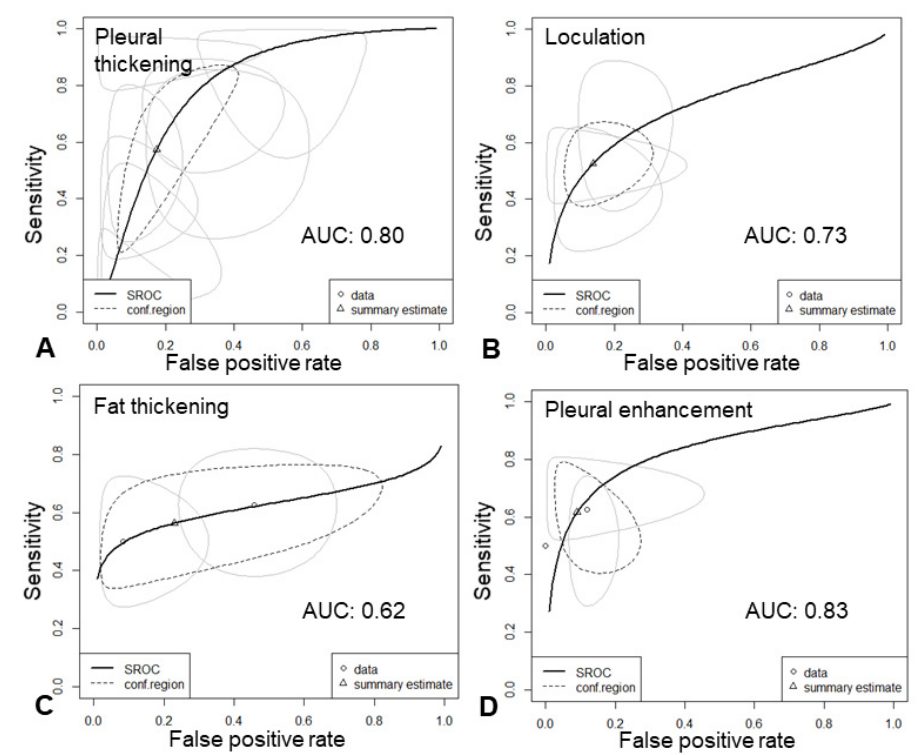
Figure A4. HSROC in parapneumonic effusions: HSROC curve in black with confidence region (dashed line) of the pleural findings ( A ): Pleural thickening, ( B ): Loculation, ( C ): Fat thickening and ( D ): Pleural enhancement (each shown as a point and 95% confidence region as a gray ellipse).